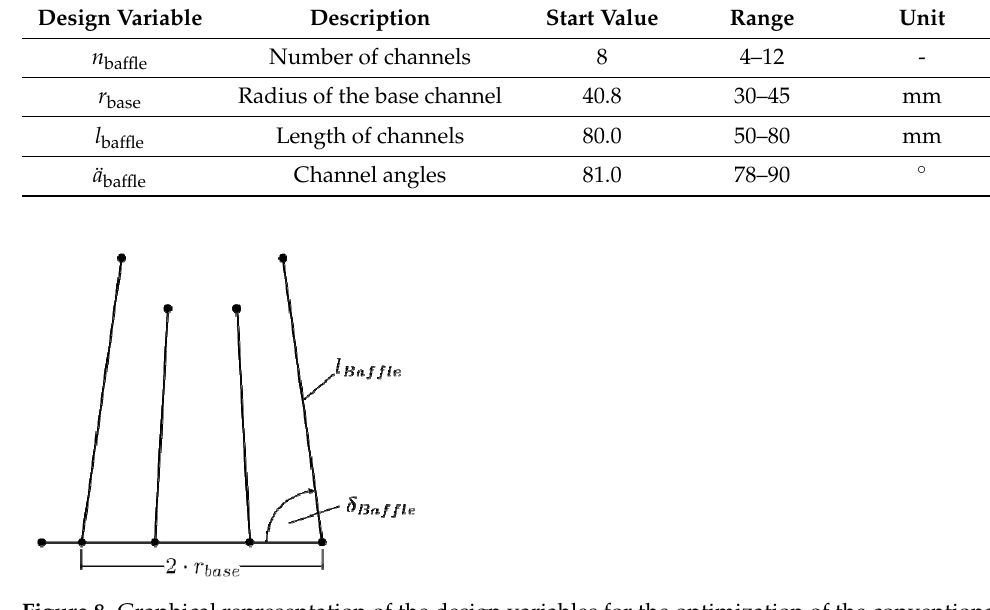
Table 3. Design variables for the optimization of the conventional cooling system.